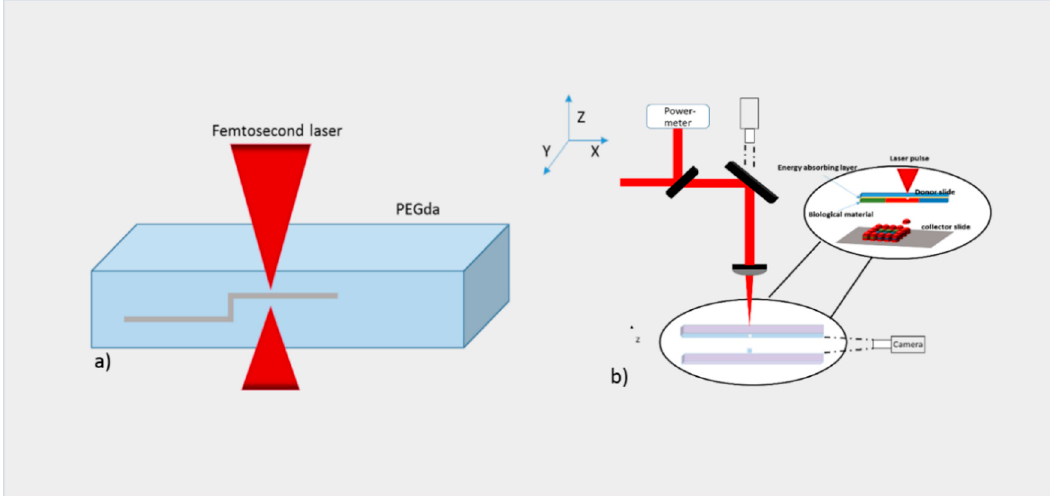
Figure 13. ( a ) Schematic representation of two photon polymerization process of an acrylated poly(ethyleneglycol) (PEG). ( b ) Schematic representation of LIFT technique for the printing of cells on the fabricated scaffold. [120].